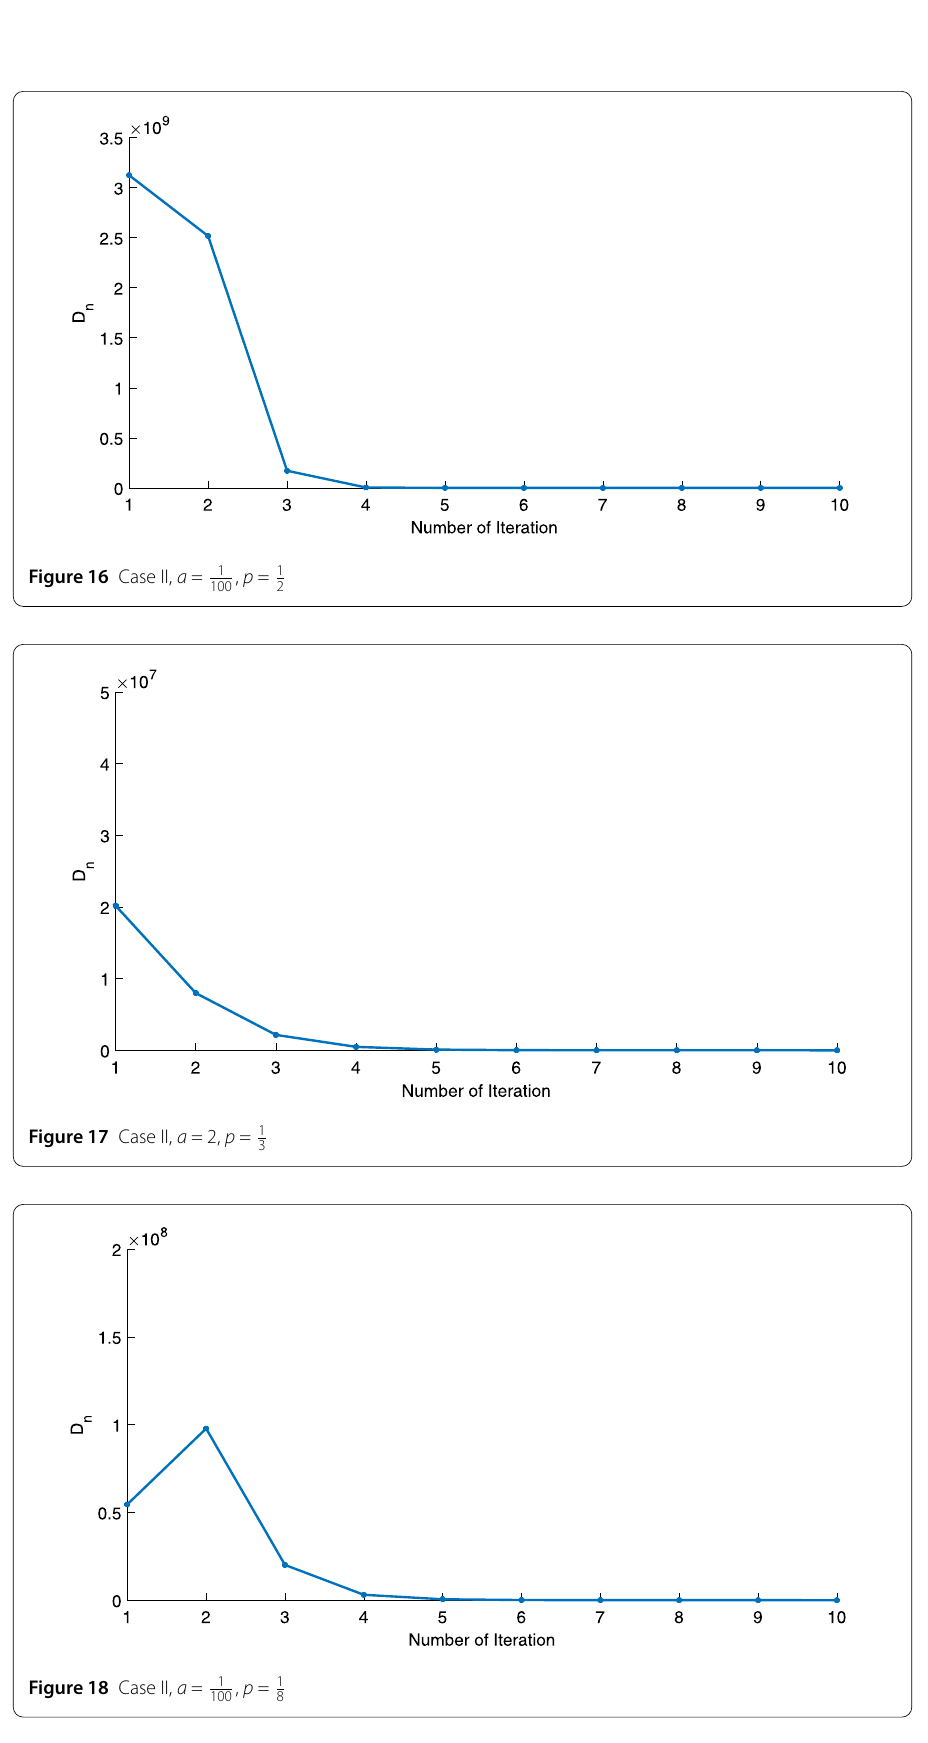
Figure 18 Case II, a = 1